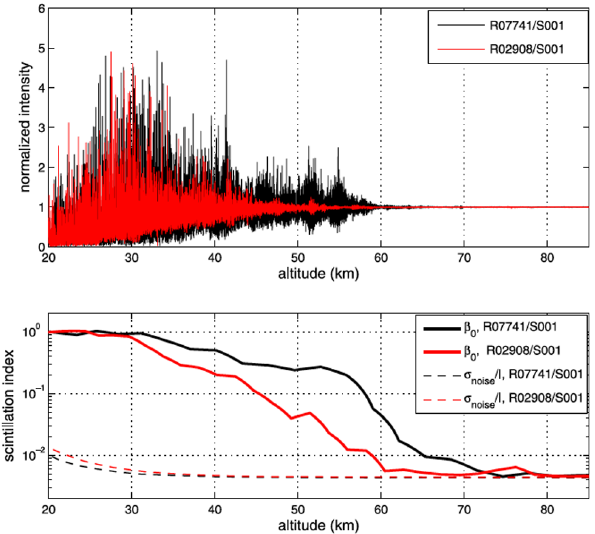
Fig. 49. Top: photometer signals by the GOMOS red photometers in occultations R07741/S001 (62 ◦ S, 7 ◦ E, 23 August 2003, 23:51UTC) and R02908/S001 (37 ◦ S, 106 ◦ W, 20 September 2002, 07:01UTC). (bottom) Scintillation index ( β ) for these two occultations (from Sofieva et al., 2007). Fig. 50. Observation scheme of the two-wavelength scintillation. (top) A cut of the atmosphere by the plane containing B (blue) and R (red) rays (thick solid lines), which are received at the same time, t0, by the GOMOS fast photometers (FP). The ray curvature and the refraction angle ε are largely exaggerated. Thick dashed line denotes a blue ray having the same ray perigee altitude as the red one, but coming to GOMOS FP with a refractive time delay dt. (bottom) A cut of the atmosphere by the atmospheric screen. Solid lines denote trajectories of the intersection points of the rays with this plane. Shading illustrates chromatic ‘‘thickness’’ Δ R and Δ B of the rays, due to the filters optical bandwidth. The photometers simultaneously register the rays with the same coordinate y. Sketched contours illustrate anisotropic and isotropic irregularities of air density (from Gurvich et al., 2005).